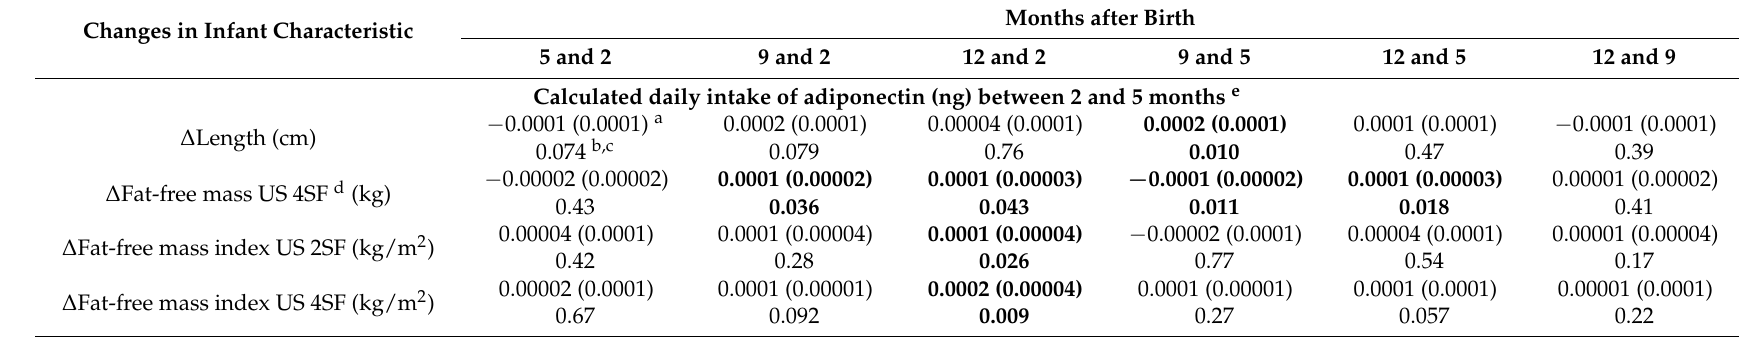
Table A7. Associations between calculated daily intakes of whole human milk adiponectin at given time points and infant body composition changes between the time